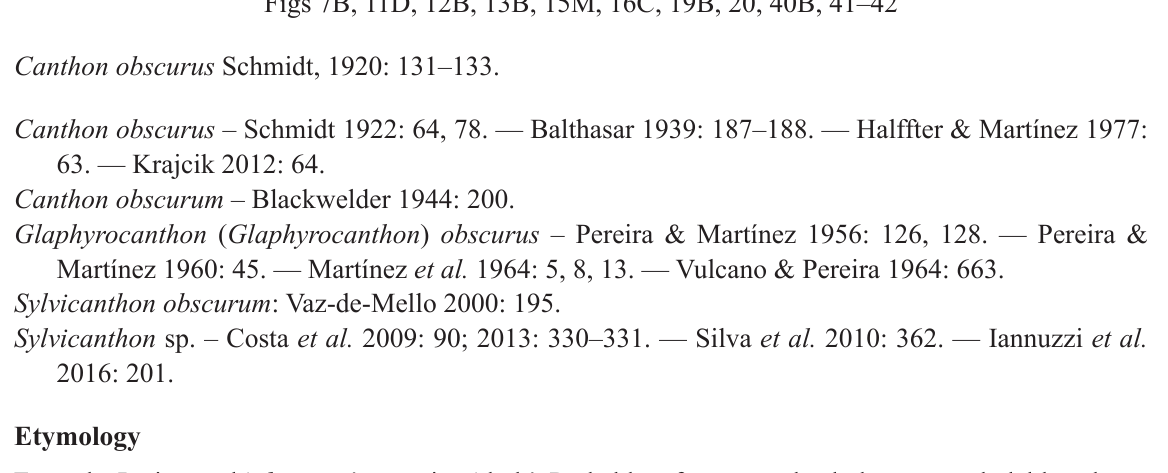
From the Latin word ‘ obscurus ’, meaning ‘dark’. Probable reference to the dark green or dark blue